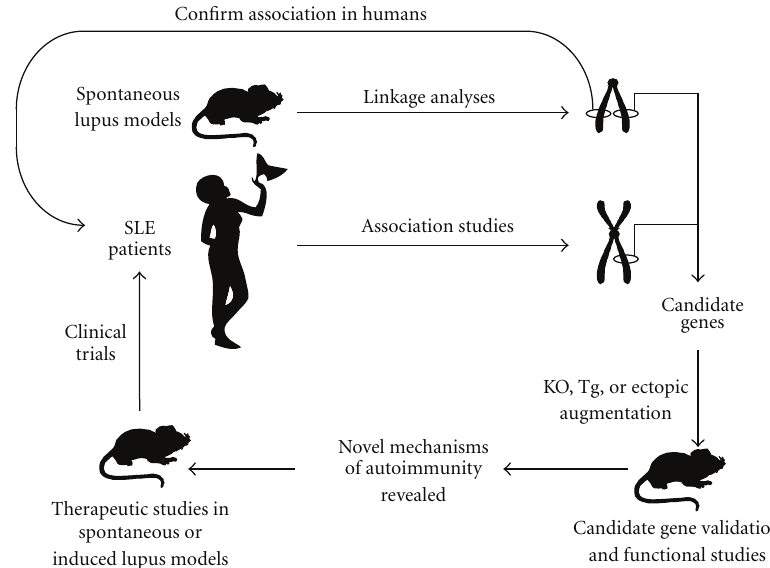
Figure 1: Integration of human and murine studies for new SLE drug discovery. Study of human SLE patients and mouse models of lupus has led to the identification of potential therapeutic targets. In-depth studies in murine models are undertaken to validate the association of the potential targets with disease symptoms. The e ffi cacy of targeted treatments are first tested on murine models of lupus prior to the initiation of human clinical